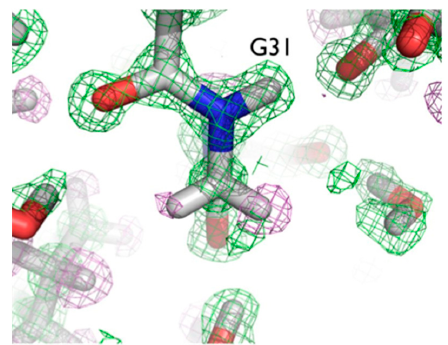
Figure 6. Nuclear 2F o − F c density for crambin residue Gly31, with negative (pink) density for H and positive (green) for other atoms, showing different degrees of H/D exchange for the two alpha carbons. Figure reproduced from [20].